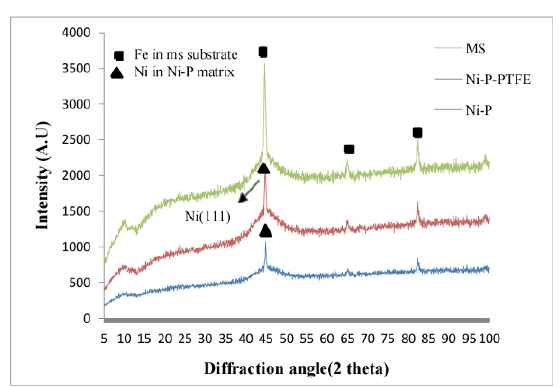
Figure 4. OCP curves for mild steel (ms) and Ni-P coating after dif- ferent exposure times in 3.5% solution of NaCl: zero days (0D), ten days (10D), and twenty days(20D).